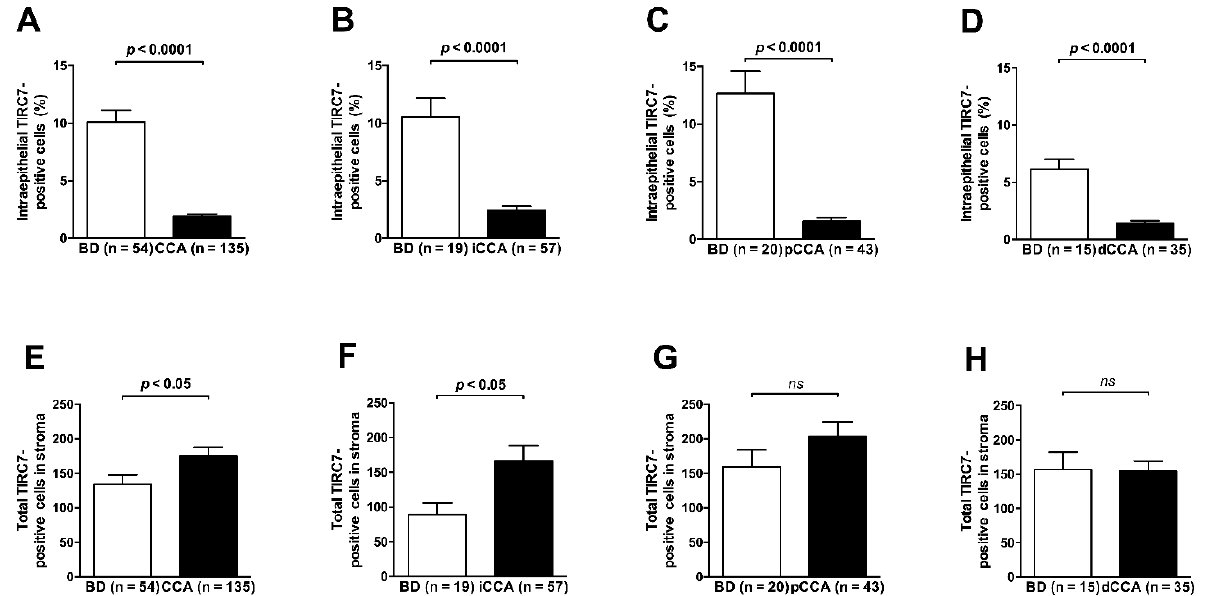
Figure 2. Quantitative analysis of TIRC7 + immune cells in tumor and nontumor tissue. Intraepithelial density of TIRC7 + immune cells was significantly reduced in tumor tissue as compared to matched non-neoplastic bile duct (BD) epithelia (available for a subset) across all CCAs ( A ) as well as in the subgroup analysis for iCCA ( B ), pCCA ( C ) and dCCA ( D ). Total number of TIRC7 + cells in the stromal compartment was significantly higher in tumor as compared to nontumor tissue when all CCAs were included ( E ), which can be attributed to significantly higher levels in iCCA cases ( F ). No significant differences were found regarding pCCA ( G ) and dCCA ( H ) tissue with respect to the stromal compartment. For all analyses the Mann–Whitney U test was used. Data are depicted as mean ± standard error of the mean.